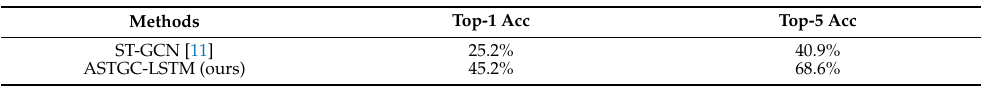
Table 3. Performance comparison with the karate technical action dataset of the ST-GCN and our